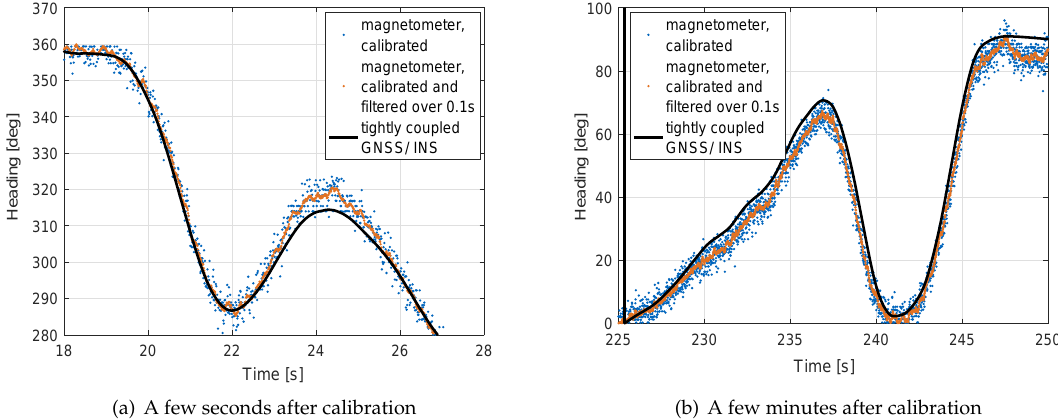
Figure 7. Detailed analysis of heading performance for two sections with moderate to high rotational dynamics: the filtered magnetometer-based heading deviates by less than 10 degrees from the GNSS/INS tightly coupled heading.